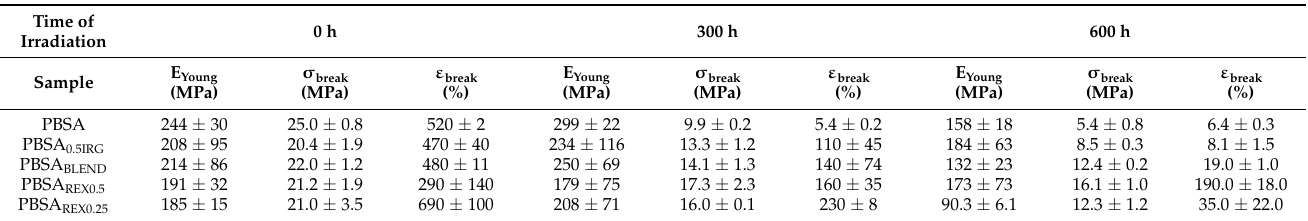
Table 3. Mechanical properties of PBSA formulations at initial stage (t = 0 h) and after 300 h and 600 h of aging test. All the values here reported were obtained from the average value of 5 tests along with their standard